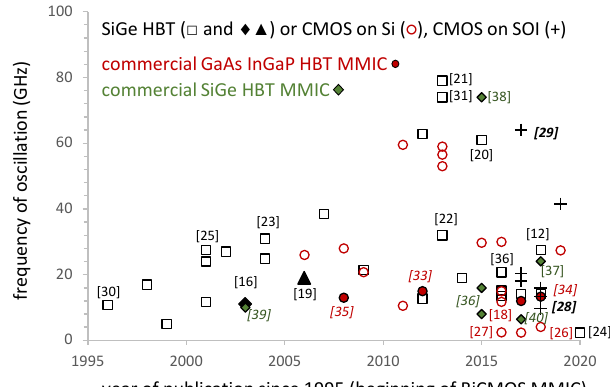
Figure 6. Evolution of oscillating frequencies for MMIC (Bi)CMOS VCOs from 1995 to 2020. Some references used in the paper are noted close to the associated symbol